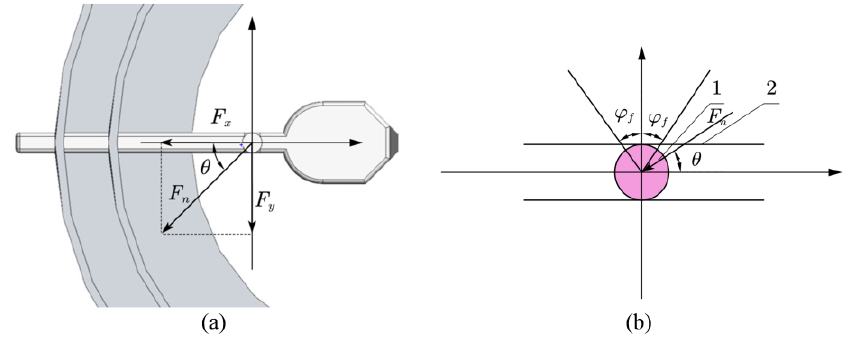
of the circle center of the cylindrical slider as the coordinate origin.